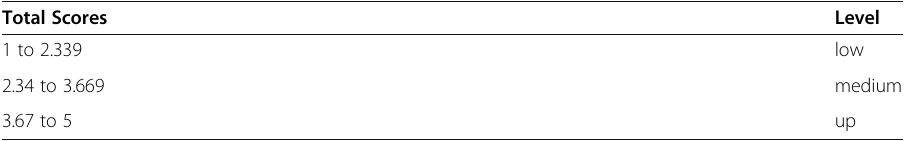
Table 1 Determining the level of the scores of variables Total Scores Level 1 to 2.339